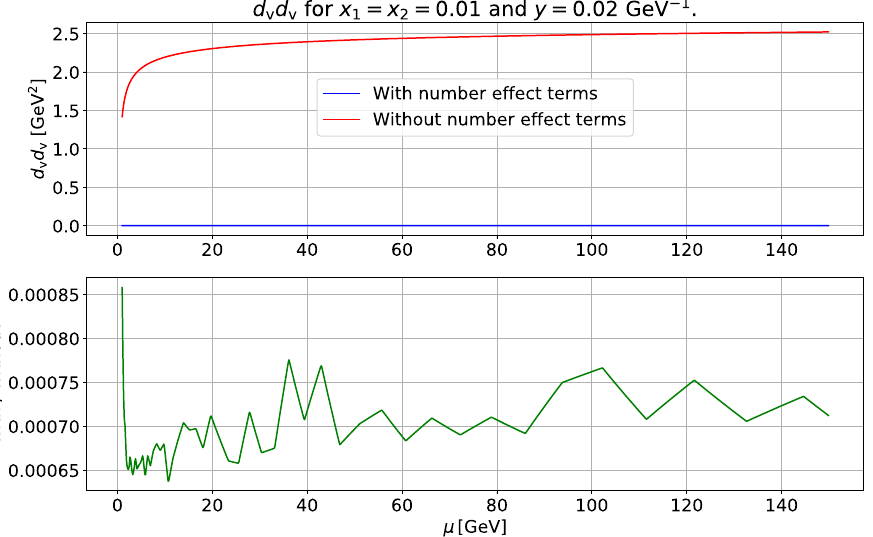
Figure 15 . Valence-valence component of dd for two di(cid:11)erent kinds of initial conditions. The distribution in blue has been generated with initial conditions that include the number e(cid:11)ect terms, whereas the one in red use initial conditions that do not include any number e(cid:11)ect term.